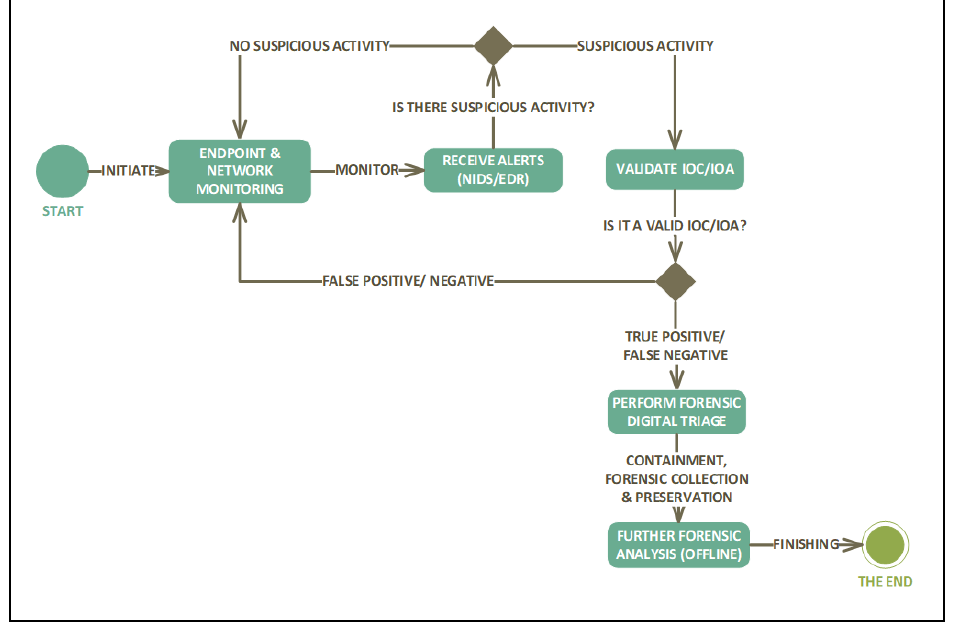
Figure 1. The deployment model for proactive digital forensics.